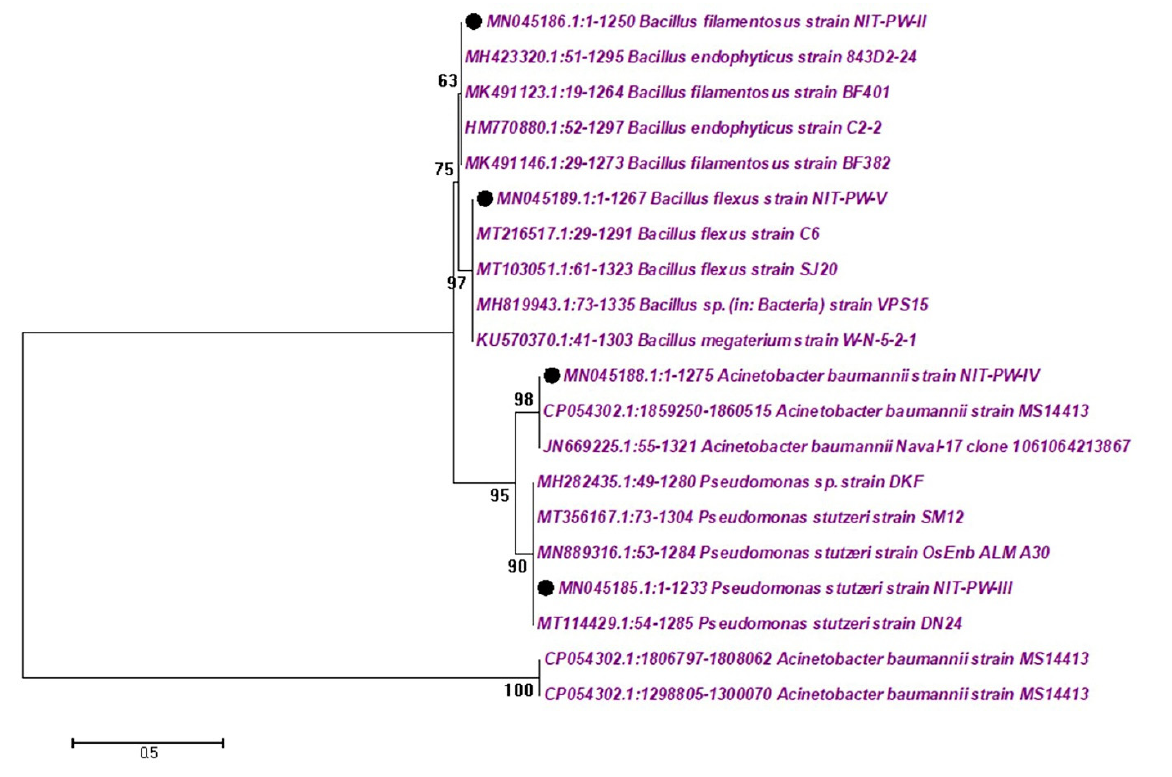
Figure 5. The isolated multidrug-resistant strains (MDRs) constructed by the phylogenetic tree are based on about 1200 partial bases of 16S rDNA gene sequences.